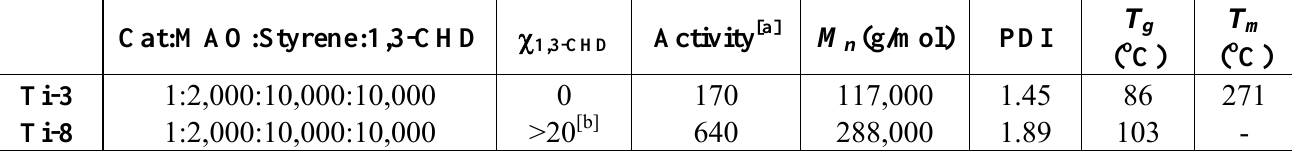
Table 4. Copolymerization of styrene and 1,3-CHD using Ti-8 and Ti-3